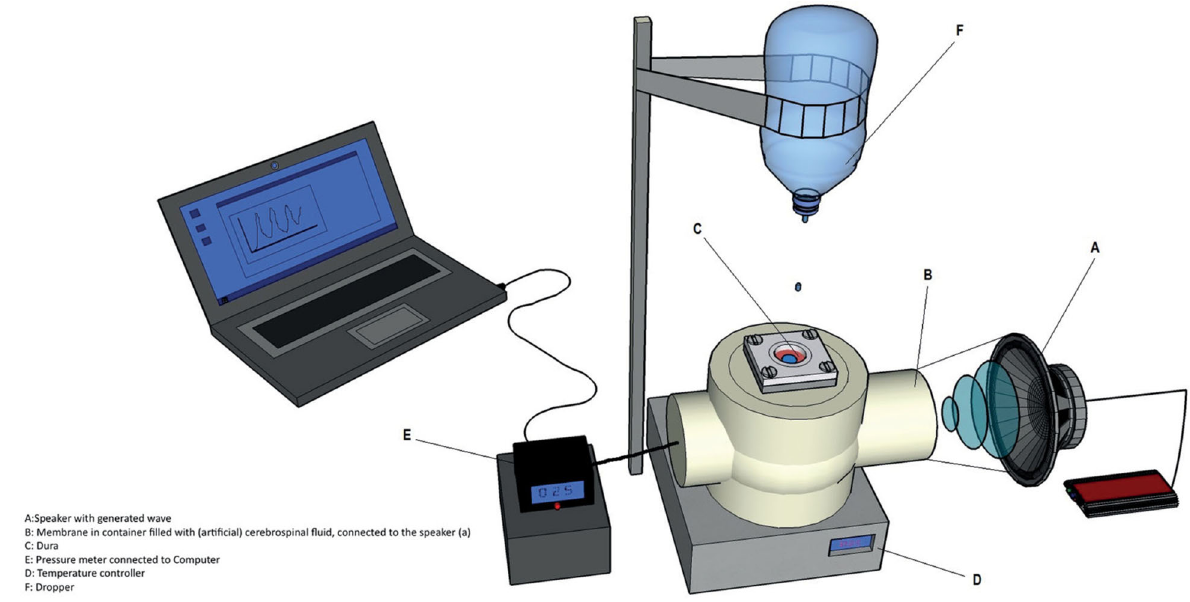
Fig. 3 Ex vivo cranial resistance setup [adapted with permission from ref.